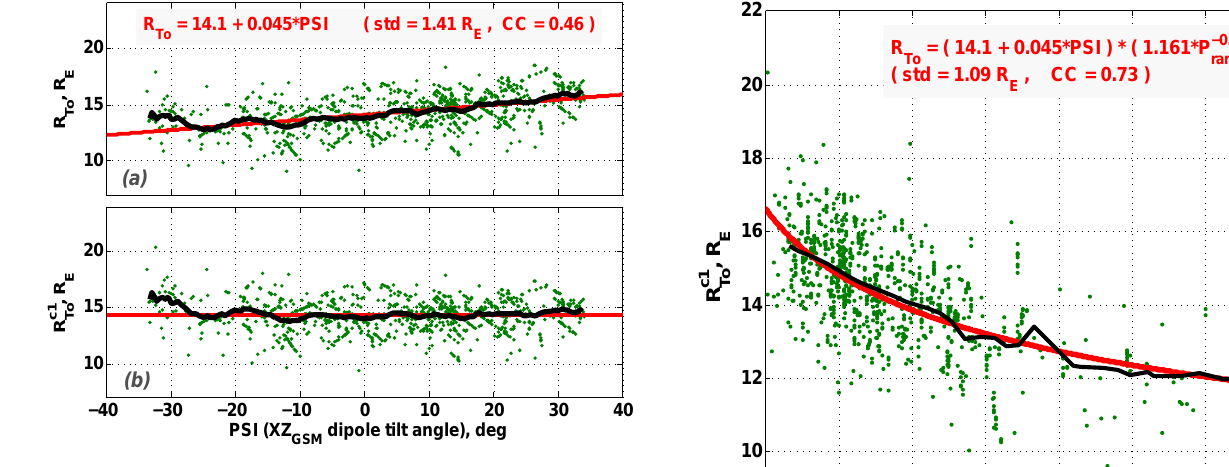
Figure A1. Top panel – scatterplot of terminator radius dependence on dipole tilt angle. Bottom panel – demonstration of results of the data correction procedure (Eq. A2) that eliminates the R T 0 ((cid:57)) de- pendence. Red straight lines are the linear regression lines. Black lines are the moving averages (window size is 3 ◦ , step size is 0.5 ◦ ).